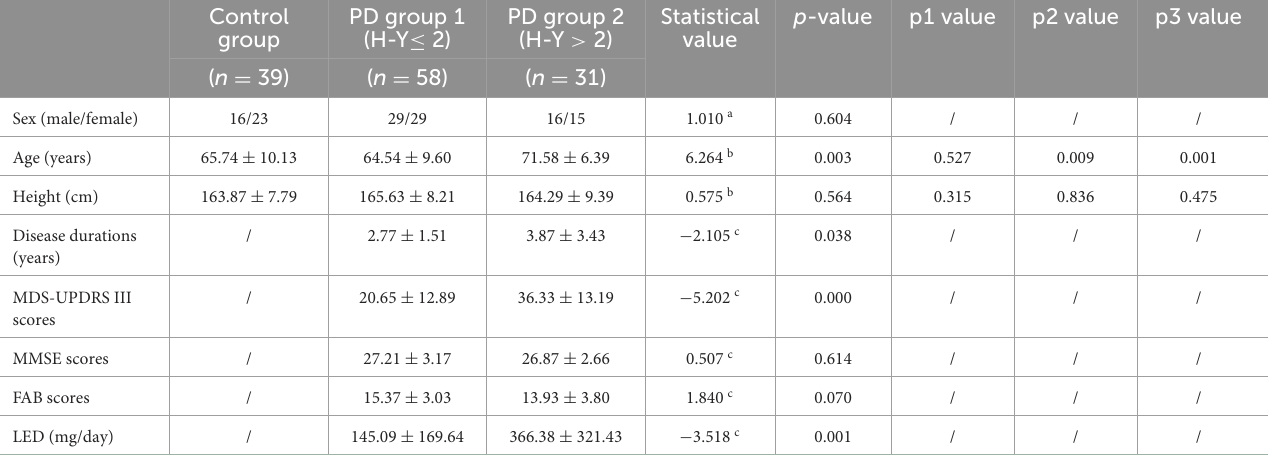
TABLE 1 Demographic information of two PD groups and control